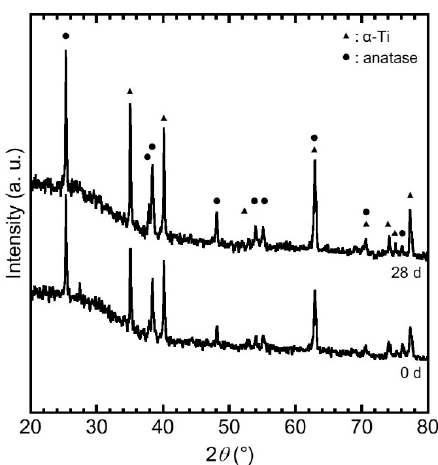
Figure 2. X-ray diffraction (XRD) spectra of the Zn-incorporated specimens before and after incubation in saline during 28 days.